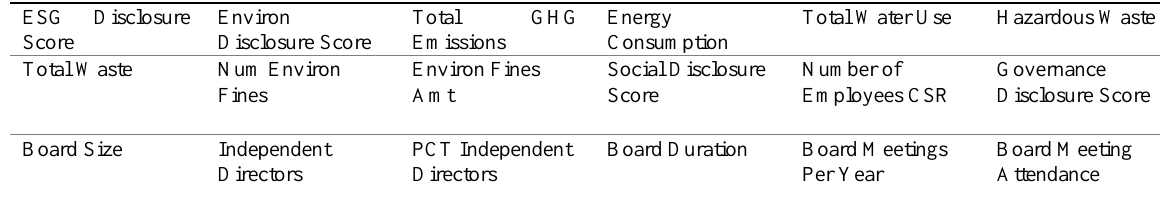
Table 3: ESG BBT Full-Variable Set Used for P&G,